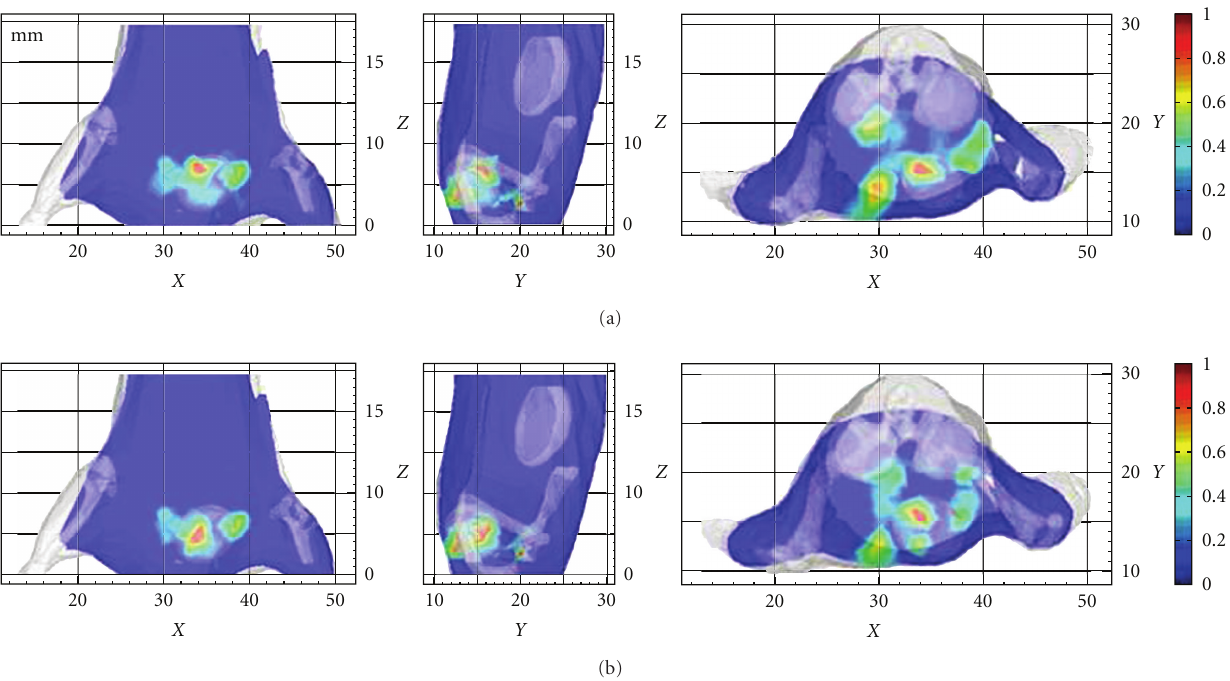
Figure 5: Slices of the in vivo flux density distribution through the reconstructed source center successively from XZ , YZ , and XY views. (a) Three slices from 3D views in HM; (b) three slices from 3D views in HR. Peak values of the flux densities in di ff erent slices were normalized to 1, in order to simultaneously demonstrate reconstructed source centers. The unit of the X , Y , and Z axes is in mm.